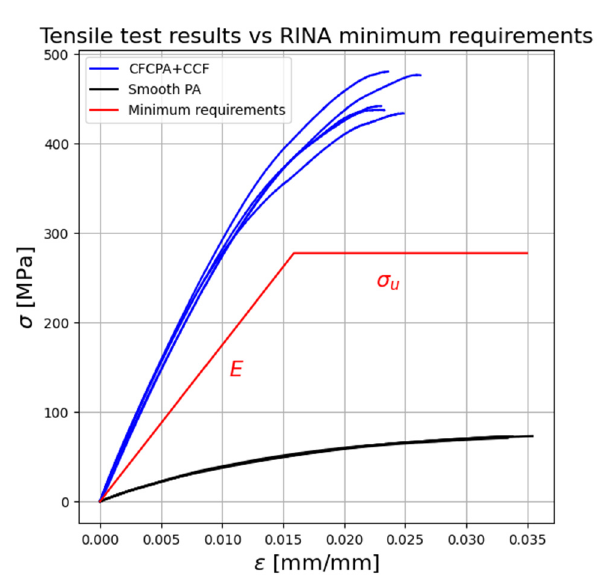
Figure 18. Tensile test results vs. Classification Society Rules minimum requirements.